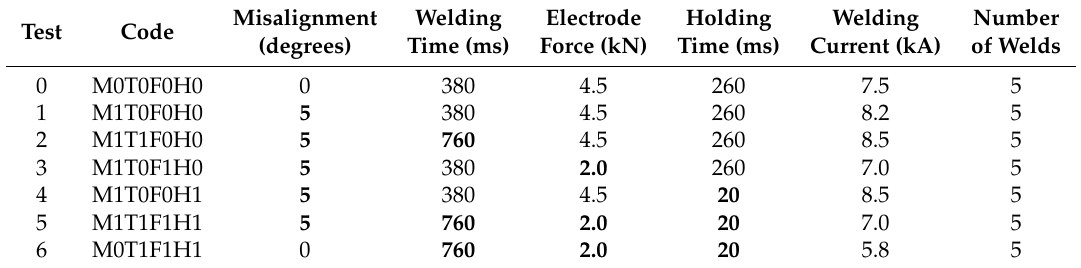
Table 1. Welding conditions in the design of experiments. Non-standard welding conditions in bold.